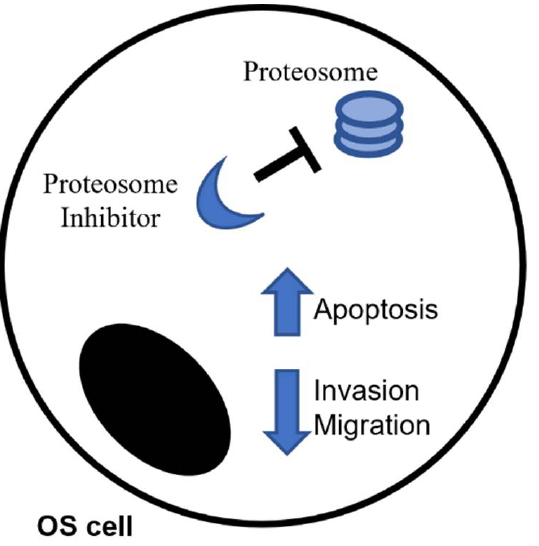
Figure 1. Proteasome inhibitors as anti-cancer drug in Osteosarcoma.